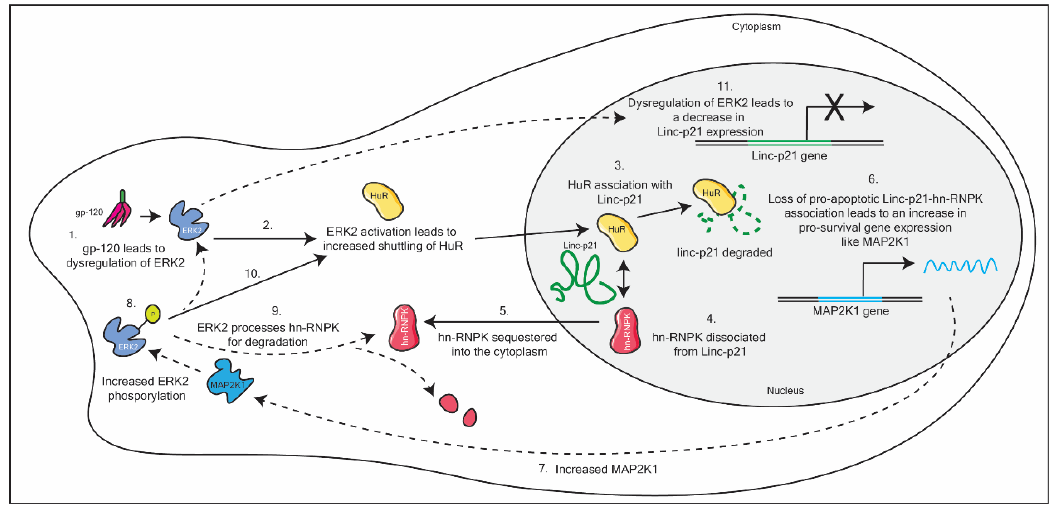
Figure 3. A schematic detailing HIV-1 dysregulation of Linc-p21 in macrophages. This dysregulation ultimately results in the evasion of apoptosis in macrophages, through a multi-step pathway. See text for details.